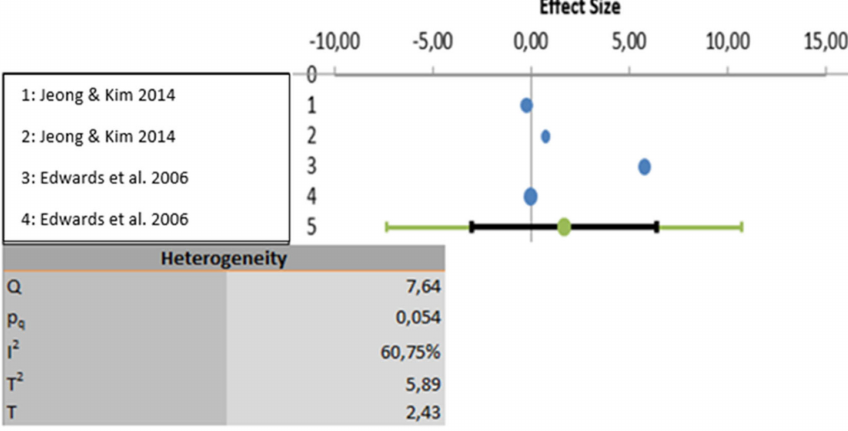
Figure 4. Data analyzed for the variable perceptions.